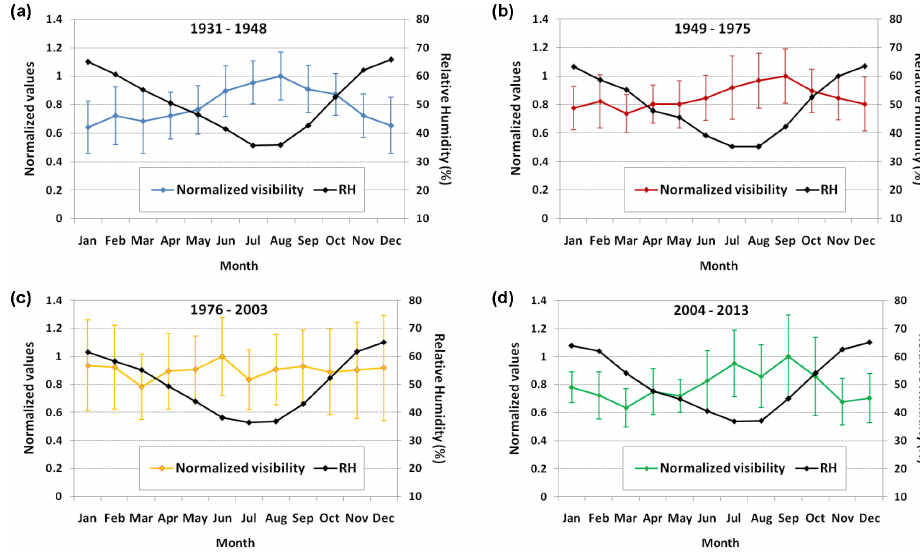
Figure 6. (a–d) Normalized mean monthly values of visibility in Athens for the subperiods (a) 1931–1948, (b) 1949–1975, (c) 1976–2003 and (d) 2004–2013, along with mean monthly values of relative humidity (RH) for each subperiod. Vertical lines represent standard deviations of mean monthly values of